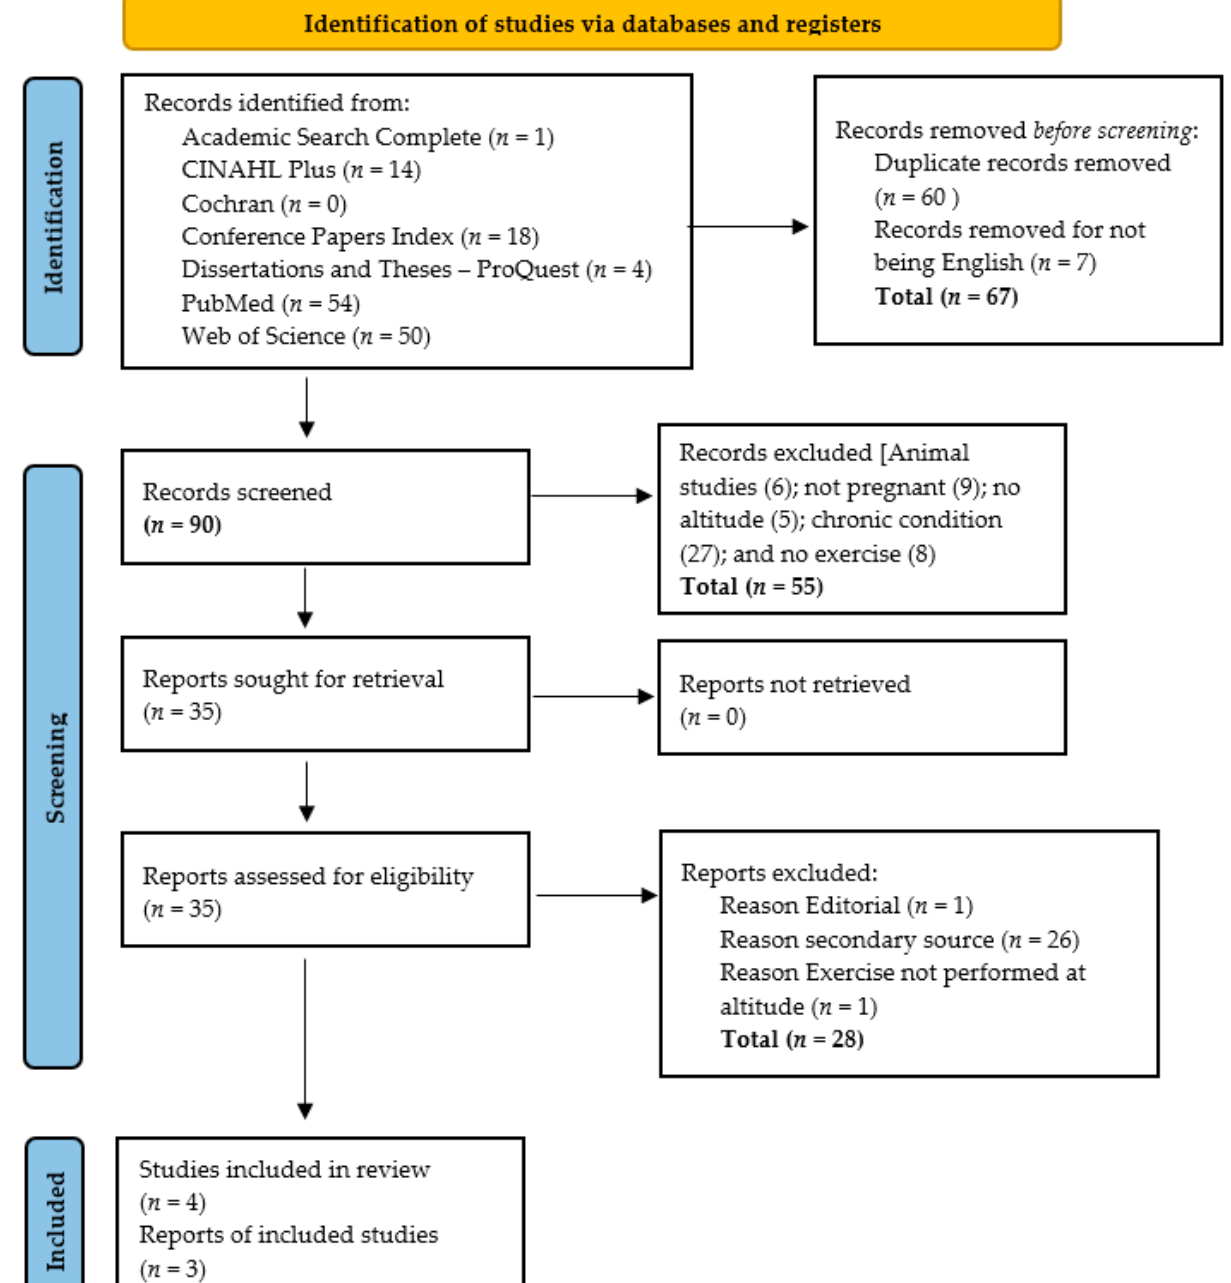
Figure 1. Search outcome and selection of articles for the integrative review. From: Page, M.J.; McKenzie, J.E.; Bossuyt, P.M.; Boutron, I.; Hoffmann, T.C.; Mulrow, C.D.; Shamseer, L.; Tetzlaff, J.M.; Akl, E.A.; Brennan, S.E.; et al. The PRISMA 2020 statement: An updated guideline for reporting systematic reviews. BMJ 2021 , 372 , n71, doi:10.1136/bmj.n71. ©Under the terms of Creative Commons Attribution License which permits unrestricted use and